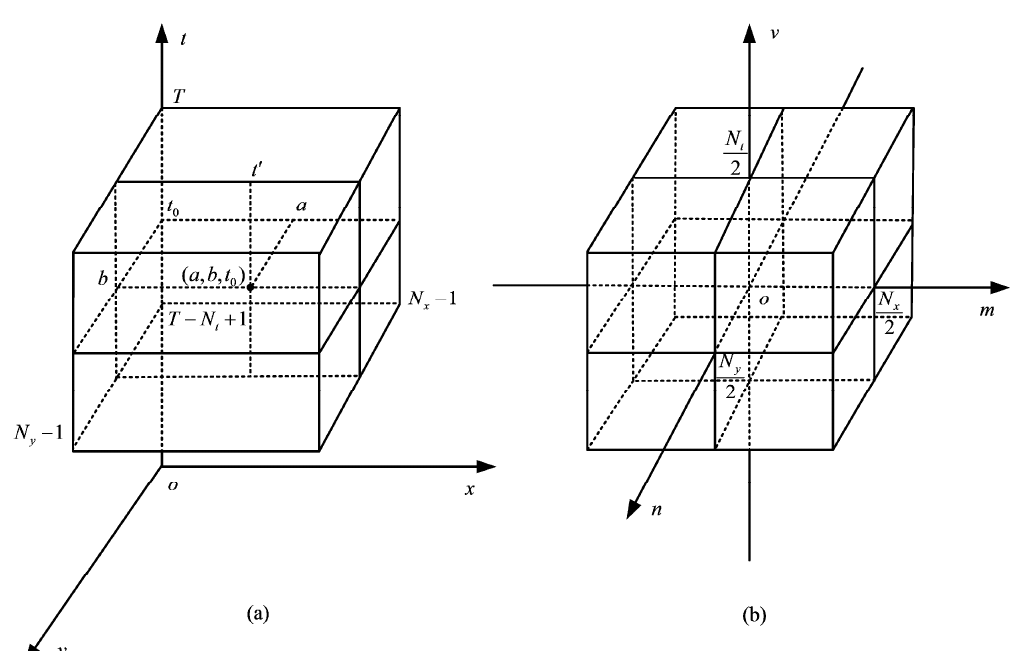
Figure 1. Illustration of a three-dimensional (3D) array f p x , y , t q and its centralized 3D frequency space